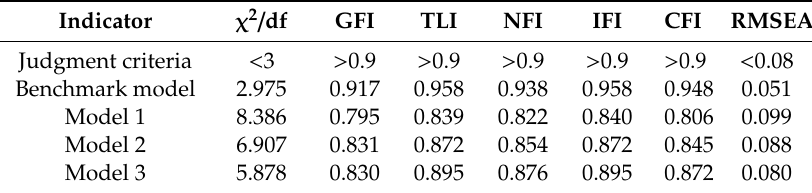
Table 4. Comparison of measurement models.